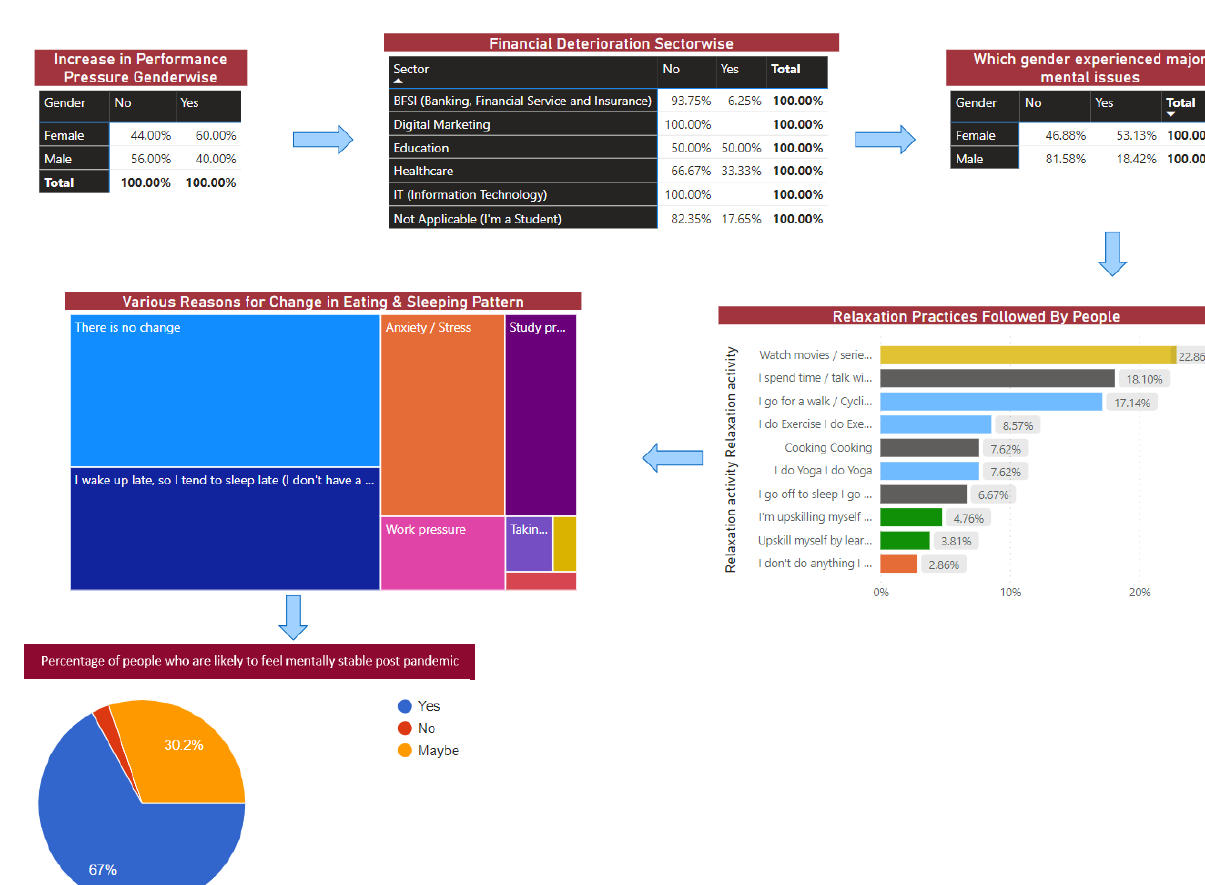
Fig. 10. Summarization of whole